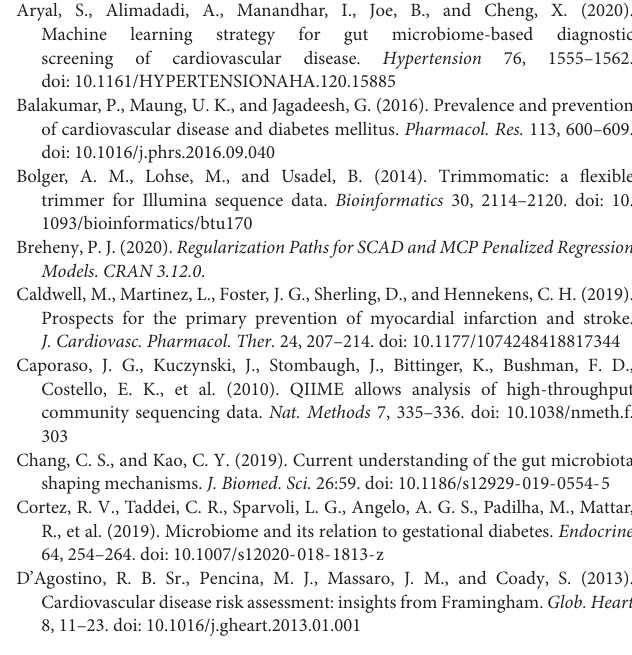
Supplementary Figure 1 | (A) Alpha diversity measures for the LR, MR, and HR groups. (B) Principal Coordinates Analysis (PCoA) based on Bray-Curtis distances of